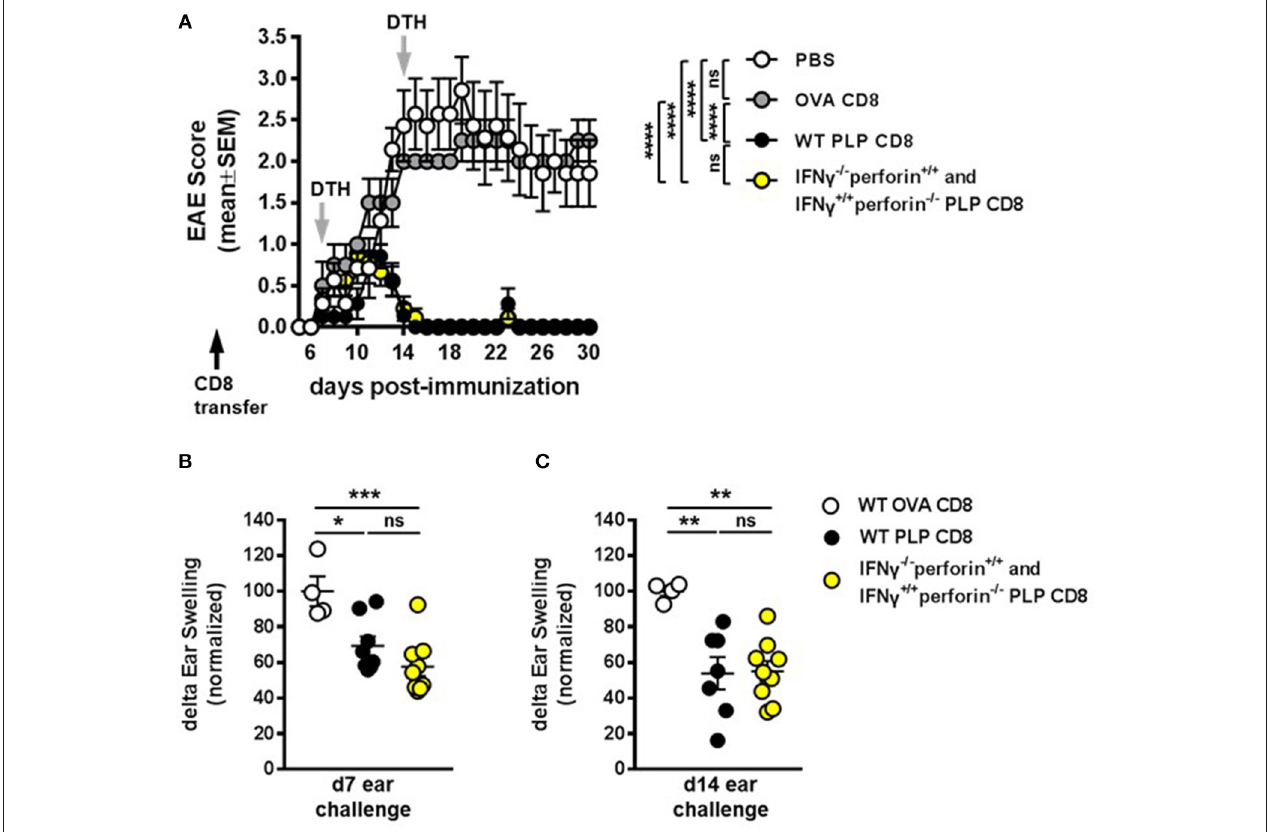
FIGURE 7 | IFN γ –/– and perforin–/– PLP-specific CD8T cells functionally compensate to protect mice from EAE. (A) On day − 1 (black arrow), mice received either PBS, 5 × 10 6 WT PLP-CD8, or 2.5 × 10 6 IFN γ –/– (perforin sufficient) plus 2.5 × 10 6 perforin–/– (IFN γ sufficient) single knockout PLP-CD8. The following day, mice were immunized with PLP178-191/CFA to induce EAE and disease scores were monitored. (B) On day 7 post-immunization (first gray arrow), right ears were challenged with PLP178-191 peptide and measured at 48h. (C) On day 14 (second gray arrow), left ears were injected with PLP178-191 peptide and measured at 48h. PBS control n = 7, OVA-CD8 n = 4; WT PLP-CD8 n = 7; mixed knockout PLP-CD8 n = 9. * p < 0.05; ** p < 0.01; *** p < 0.001; **** p <